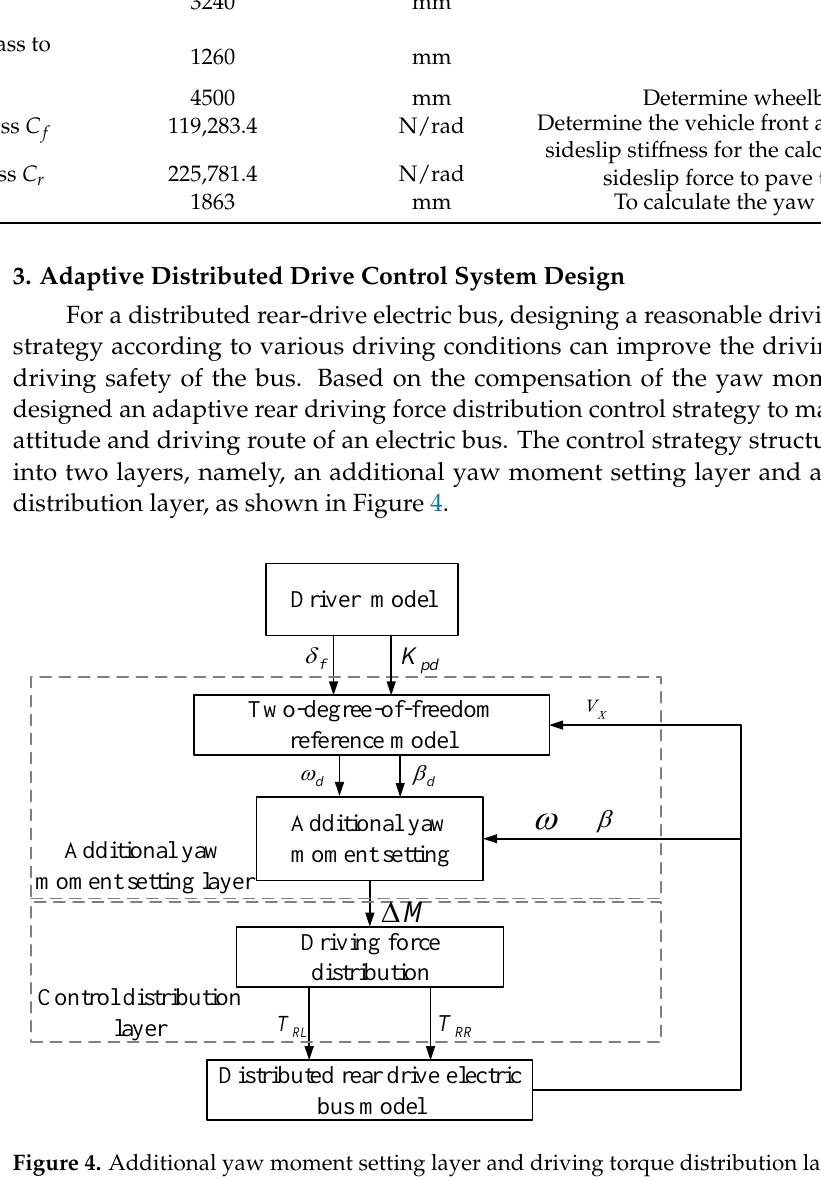
Figure 4. Additional yaw moment setting layer and driving torque distribution layer. The additional yaw moment setting layer inputs the received driver information δ f and K pd into the reference vehicle model to obtain the expected yaw rate and sideslip angle. The expected yaw rate and sideslip angle are compared with the actual yaw rate and sideslip angle, respectively, and the additional yaw moment is obtained by the adaptive fuzzy controller and input to the next layer. In the driving force distribution layer, the driving forces are reasonably distributed on the left and right rear wheels of the electric bus according to the additional yaw moment